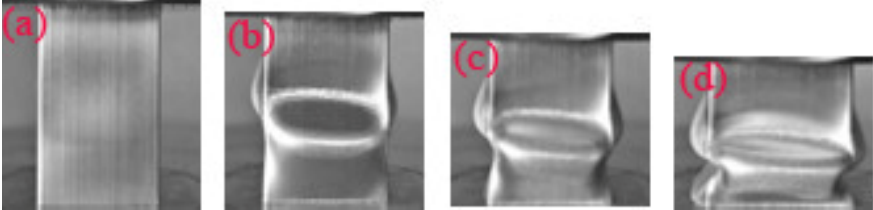
Figure 9. Typical deformation of the pyramid lattice material-filled tube with a relative density of the lattice material of 0.33 at a strain of ( a ) 2.6%; ( b ) 10%; (c) 20%; ( d ) 30%.